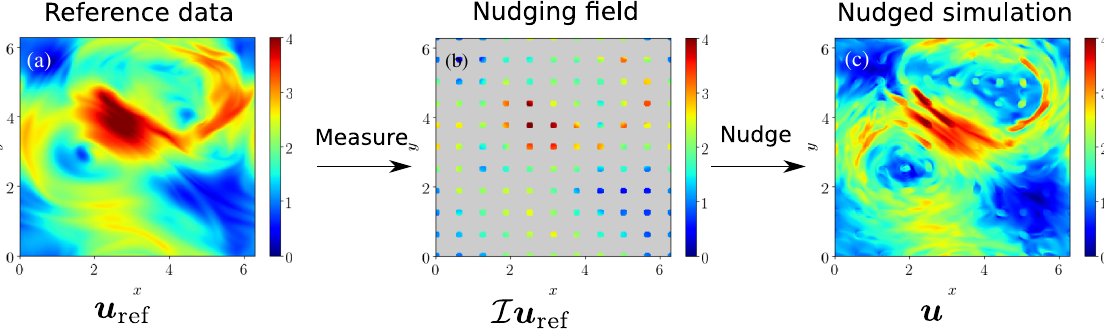
FIG. 11. Visualizations of the local energy field of (a) a reference simulation u , (b) a filtered field I u , (c) and a nudged simulation ref ref 5 . 0 , and τ =t 2 . 0 . The reference simulation has E 1 . 3 , ν ¼ 0 . 002 , N 3 ¼ 256 3 , u of a rotating turbulent flow for ϕ ¼ 0 . 15 , α t η ¼ η ¼ ref ¼ L ¼ 2 π , t 3 . 89 , t 0 . 05 , Re ¼ 5000 , and Ro ¼ 0 . 06 . The forcing f is a randomly generated, quenched in time, isotropic field L ¼ η ¼ ref ˆ f k Þ ¼ f k − 7 = 2 e i θ k , where θ with support on wave numbers with amplitudes k ∈ ½ 1 ; 2 (cid:2) whose Fourier coefficients are given by 0 k are ref ð random in ½ 0 ; 2 π Þ and f 0 ¼ 0 . 005